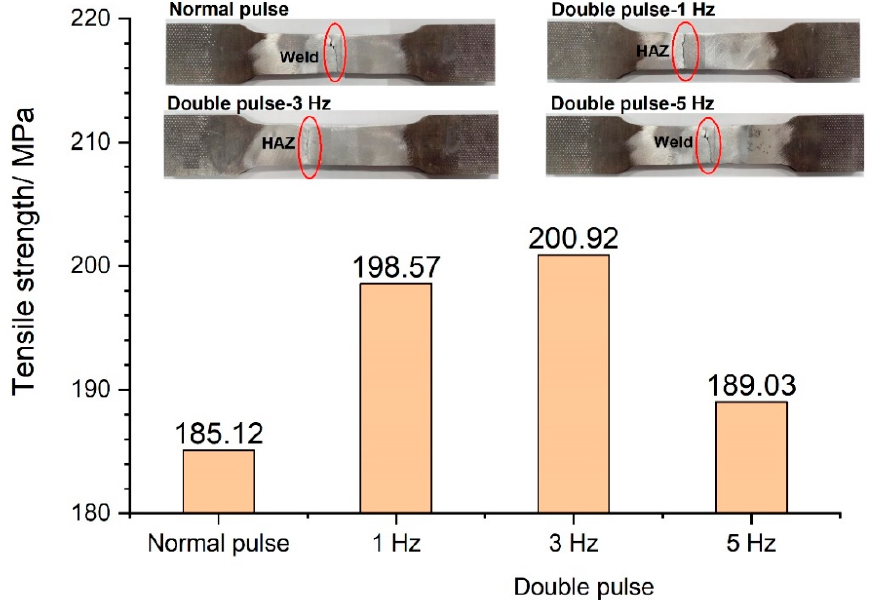
Figure 12. Tensile strength and fracture location of weld joints for the normal-pulse welding and the double-pulse welding ( f d = 1, 3, 5 Hz).